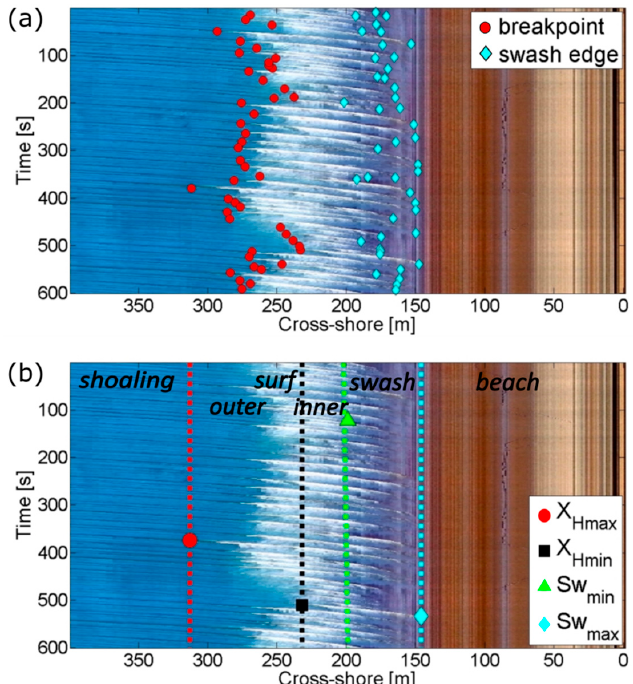
Figure 2. Visual and manual analysis of Timestack. ( a ) Single breakpoints (red circles) and swash edges (cyan diamonds) marked on Timestack; ( b ) wave transformation domains identified by the points marked on Timestack. Dashed colored lines identify the boundaries between wave domains.